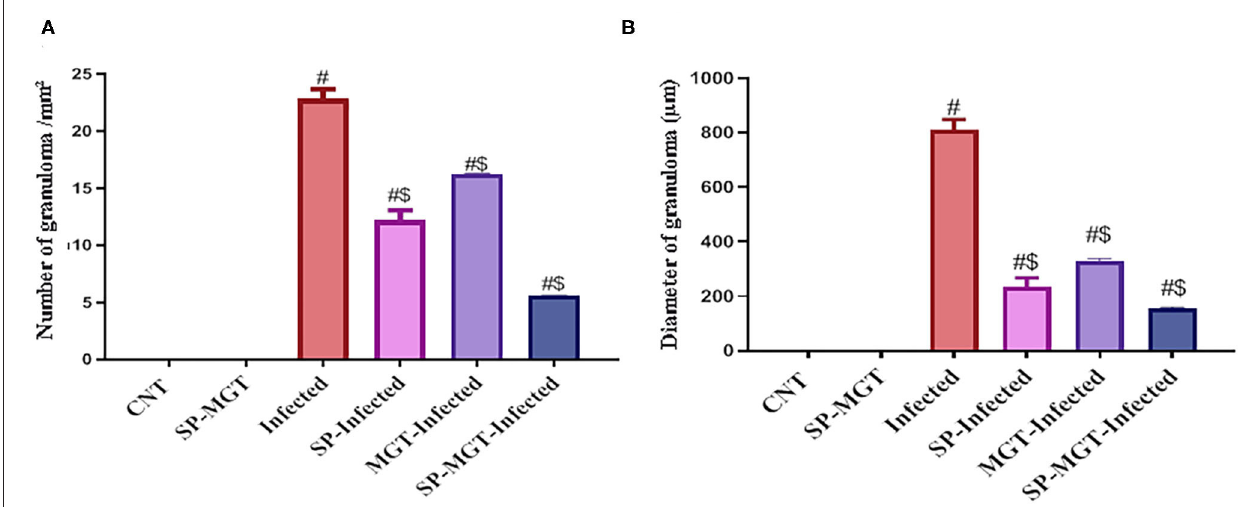
FIGURE 6 | Quantitative scoring of number (A) and diameter (B) of granuloma in hepatic tissues. Data were displayed as mean ± SEM ( n = 5/group). # or $ refers to the statistical significance at P < 0.05 against control and S. mansoni (infected) groups,